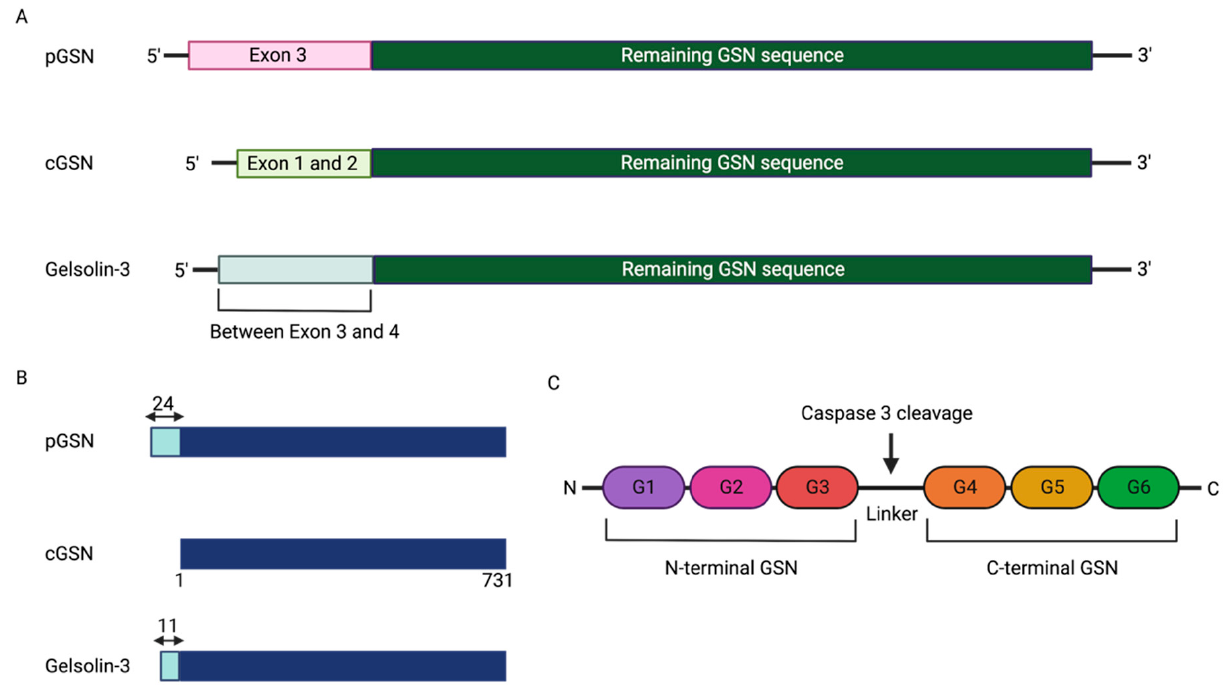
Figure 1. Gelsolin isoforms and structure. ( A ) The pGSN, cGSN, and gelsolin-3 are encoded by a single gene as a result of alternative splicing and different transcriptional initiation sites. These